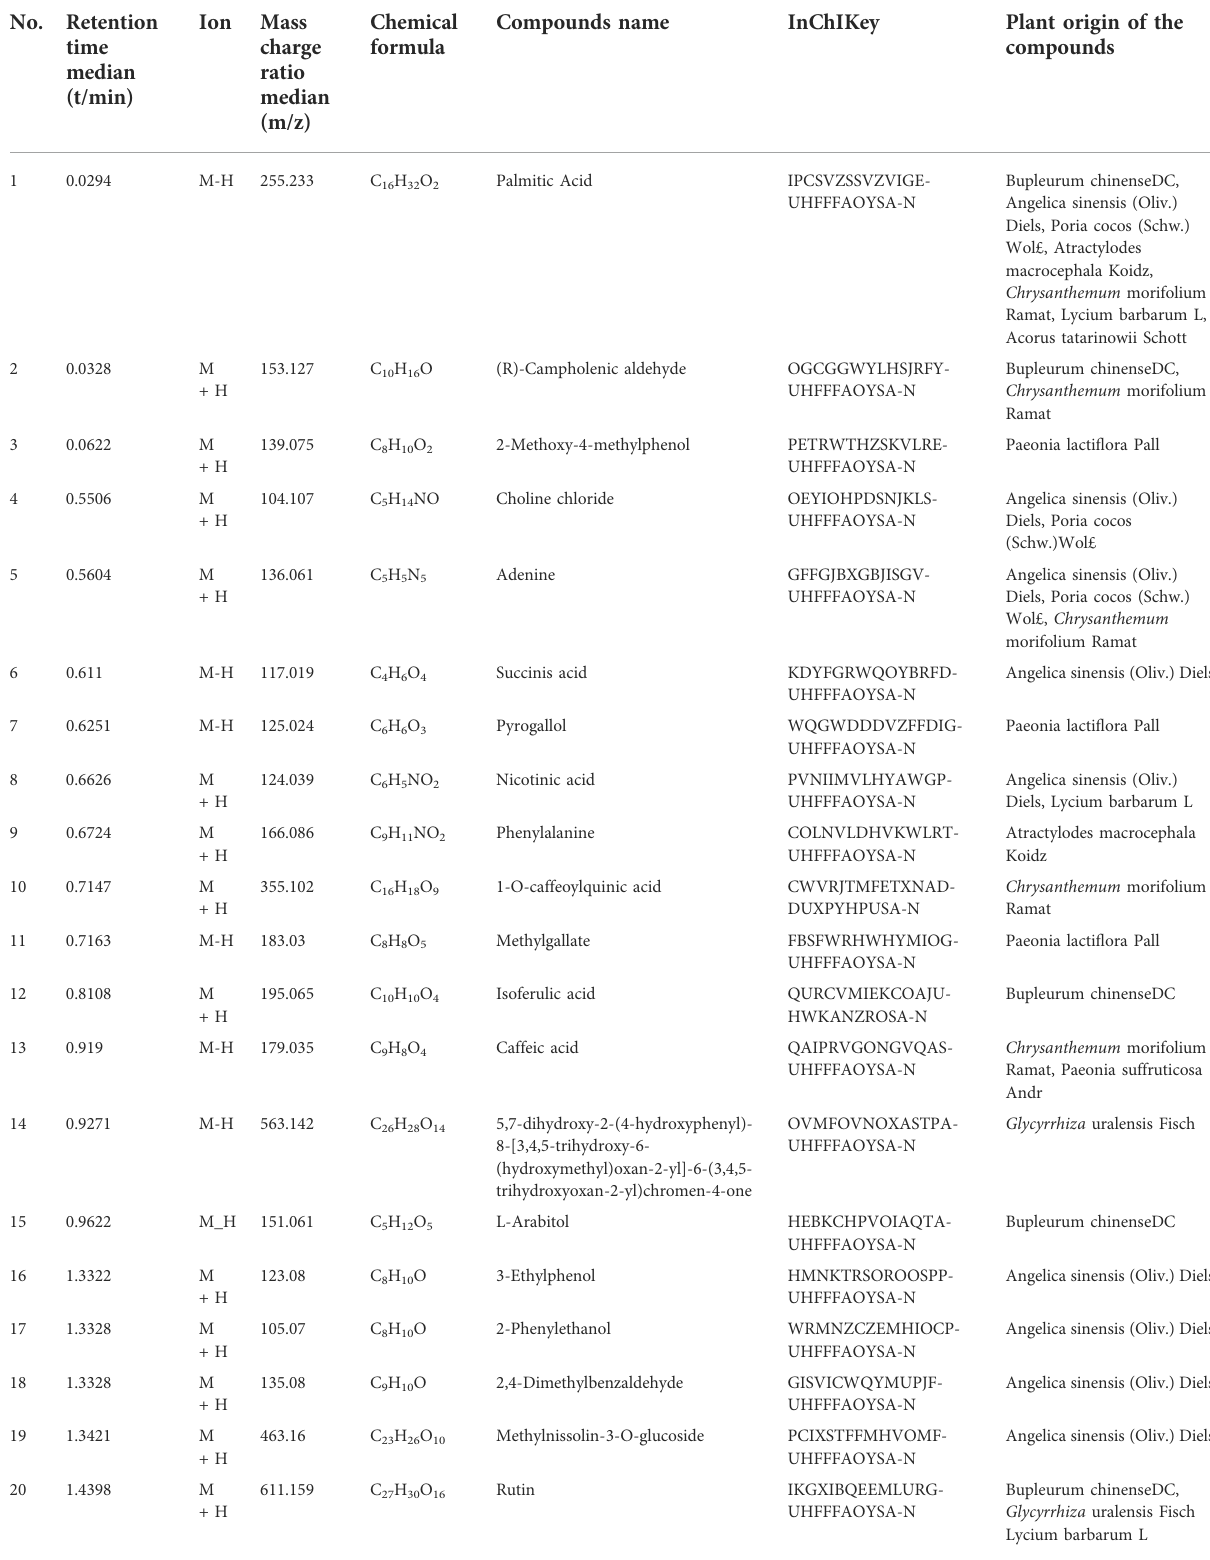
TABLE 1 Ingredients of